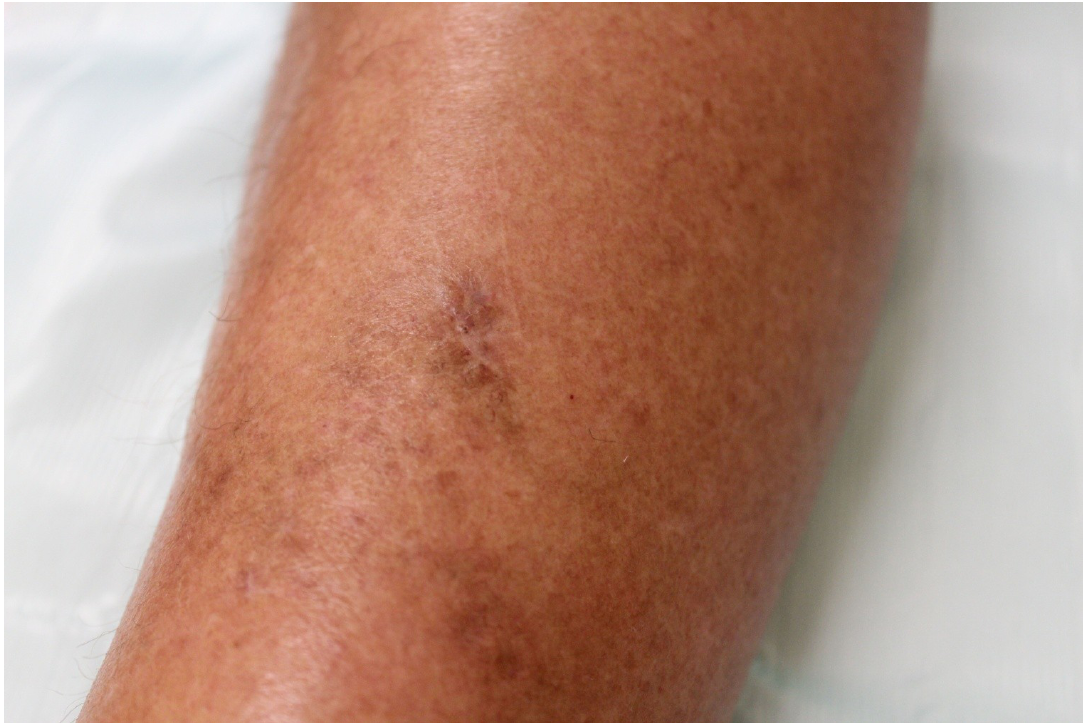
Figure 4. Residual hyperpigmented macule after